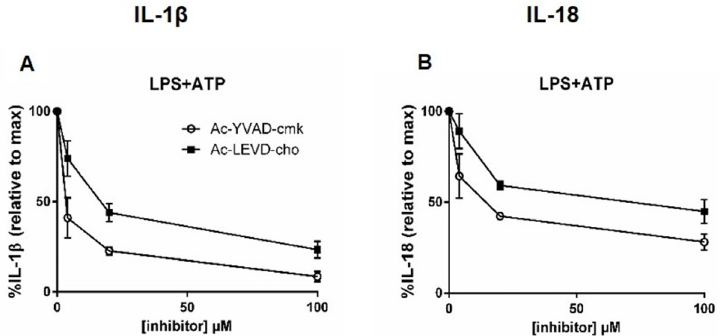
Fig 6. The effect of caspase-1 and caspase-4 inhibition on IL-1 β and IL-18 secretion. Caspase inhibition of IL-1 β release upon LPS+ATP (A) stimulation. Caspase inhibition of IL-18 release upon LPS+ATP stimulation (B). Data are expressed as mean ± % CV of duplicates from three independent